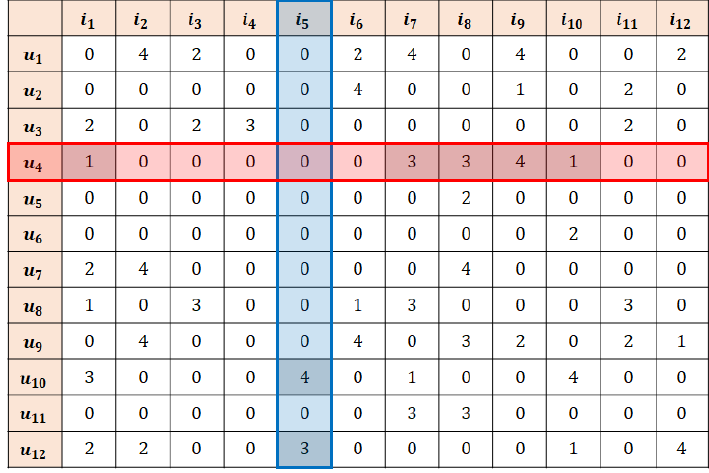
Figure 3. An example of missing data imputation of k-RRI.